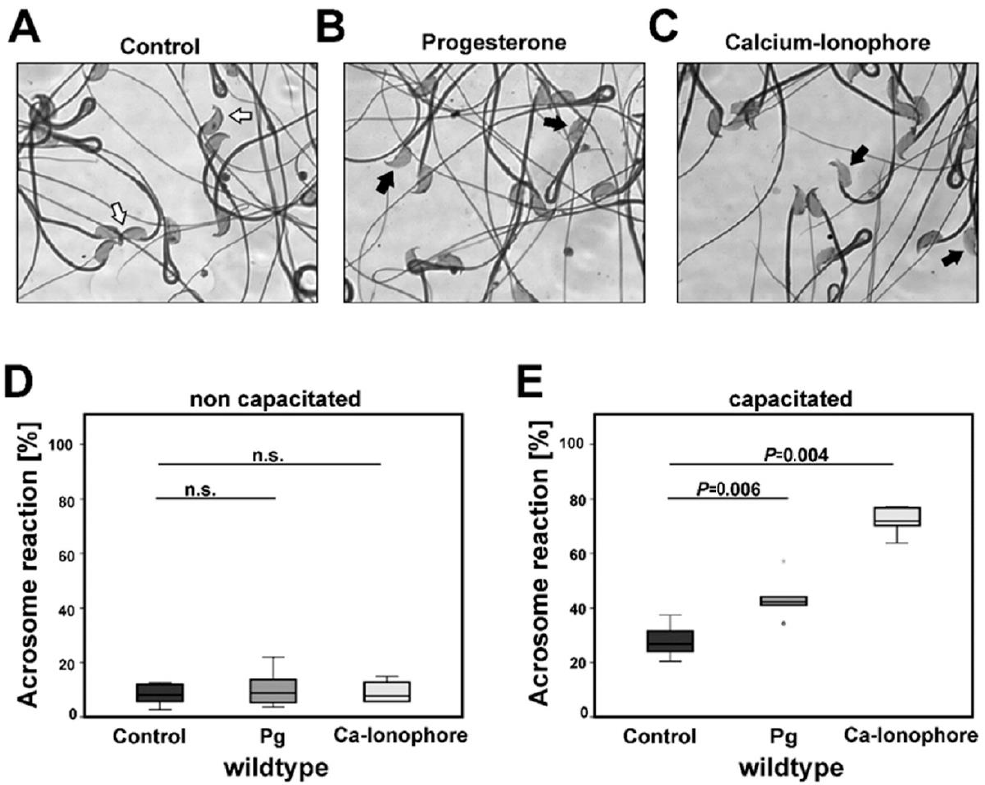
Figure 1. In vitro induction of the acrosome reaction of sperm prepared from wild-type mice. Sperm were prepared from wild-type mice (C57BL/6N). After capacitation acrosome reaction was induced by the addition of progesterone or calcium ionophore A23187 as described in the “Materials and Methods” section. ( A ) Staining of capacitated wild-type sperm. The white arrows indicate the acro- some structure. ( B ) Staining of sperm for which the acrosome reaction was initiated by progesterone. Black arrows point toward sperm that have lost their acrosomes. ( C ) Staining of sperm in which the acrosome reaction was initiated by A23187. Black arrows point toward sperm that have lost their acrosomes. 50-fold magnification. ( D , E ) Quantification of the acrosome reaction of non-capacitated ( D ) and capacitated ( E ) sperm. Significances were calculated using the Mann–Whitney U test. The experiment was carried out with six different individuals ( n = 6). The percentages of capacitated and non-capacitated acrosome reacted spermatozoa were calculated. p -values < 0.05 were considered statistically significant. n.s. not significant